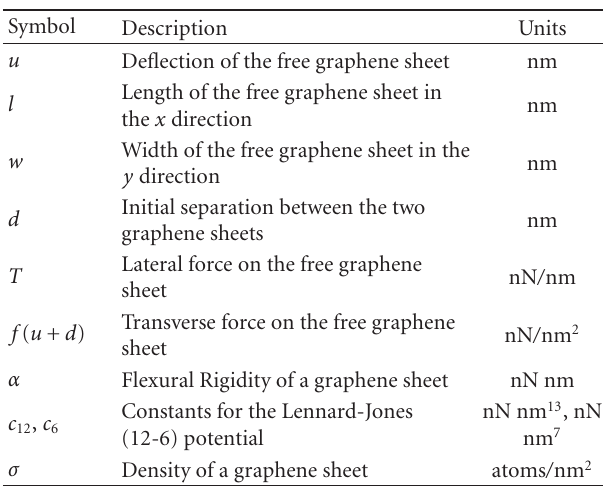
Table 1: List of variables and constants.